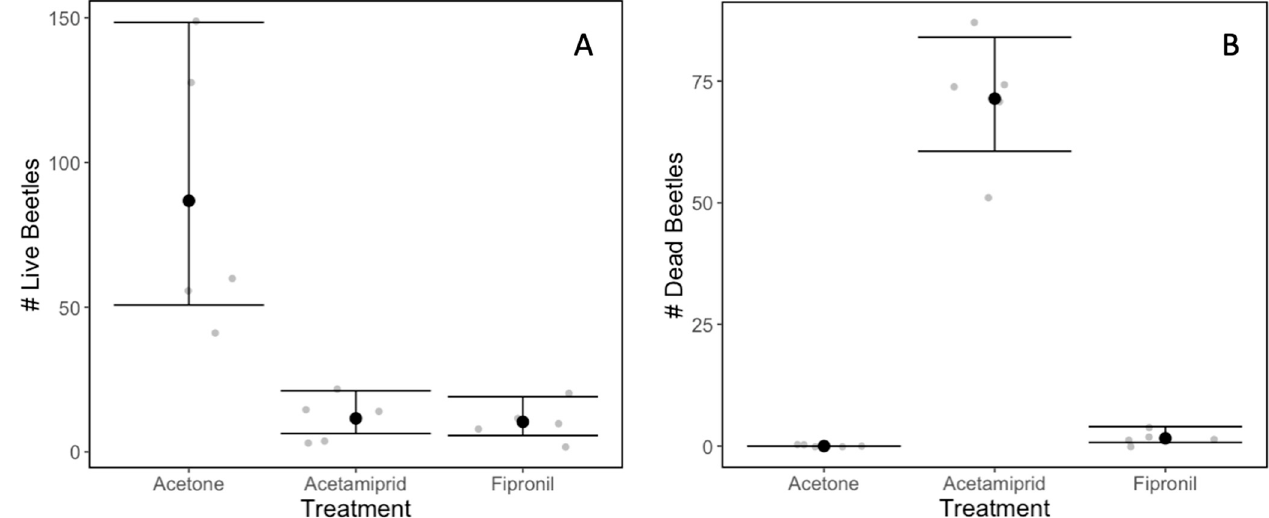
Figure 3. The 95% confidence intervals constructed from a generalized linear model with a negative binomial distribution for the average number of live small hive beetles (SHBs) aspirated from hives ( A ) and dead SHBs collected from traps ( B ) in each treatment. The averages for each treatment are depicted by a large dot with the confidence interval extending above and below it. Smaller dots represent the number of SHBs collected from the individual hives. Treatment means without overlapping confidence intervals are significantly different from one another.